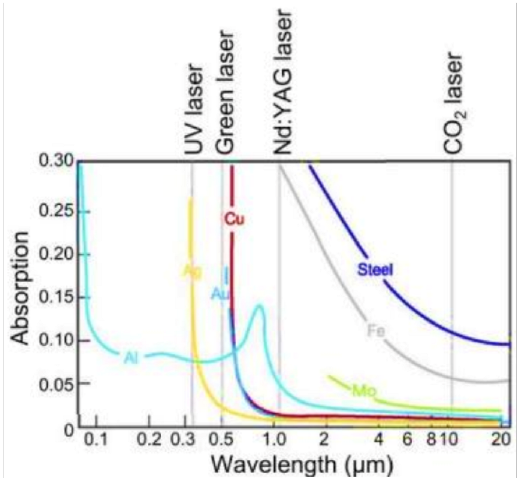
Figure 6. The absorption variation of laser emission at different wavelengths for the main material categories